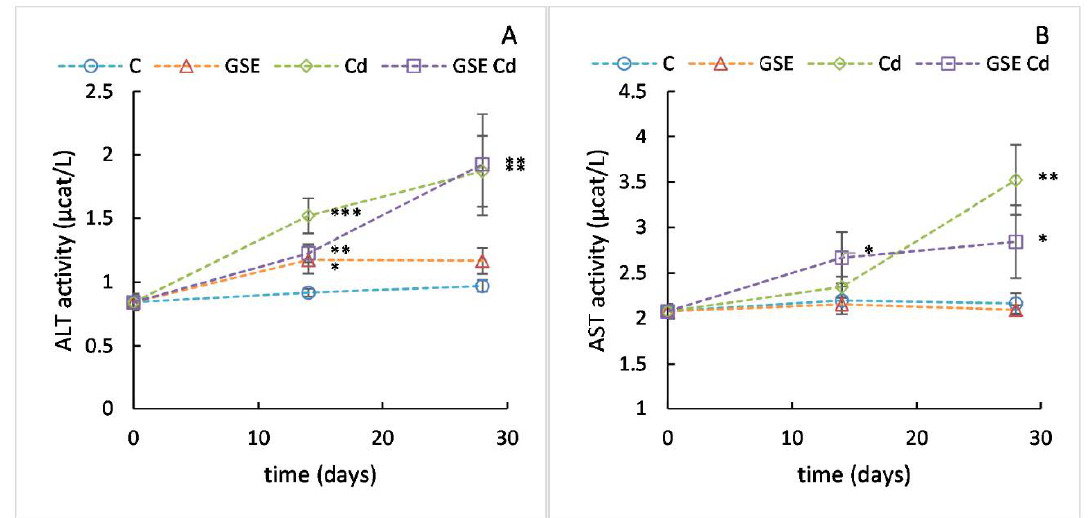
Figure 4. Plasma ALT ( A ) and AST ( B ) content values for the control variant (blue line with circles), the variant with GSE addition (orange line with triangles), the variant with Cd addition (green line with diamonds), and the variant with both GSE and Cd addition (violet line with squares) on days 0, 14, and 28 of monitoring. Data are presented as means ± sd from three replicates. Data were analyzed by one-way ANOVA (each time point separately) and differences from control are marked: * indicates p ≤ 0.05, ** indicates p ≤ 0.01, *** indicates p ≤